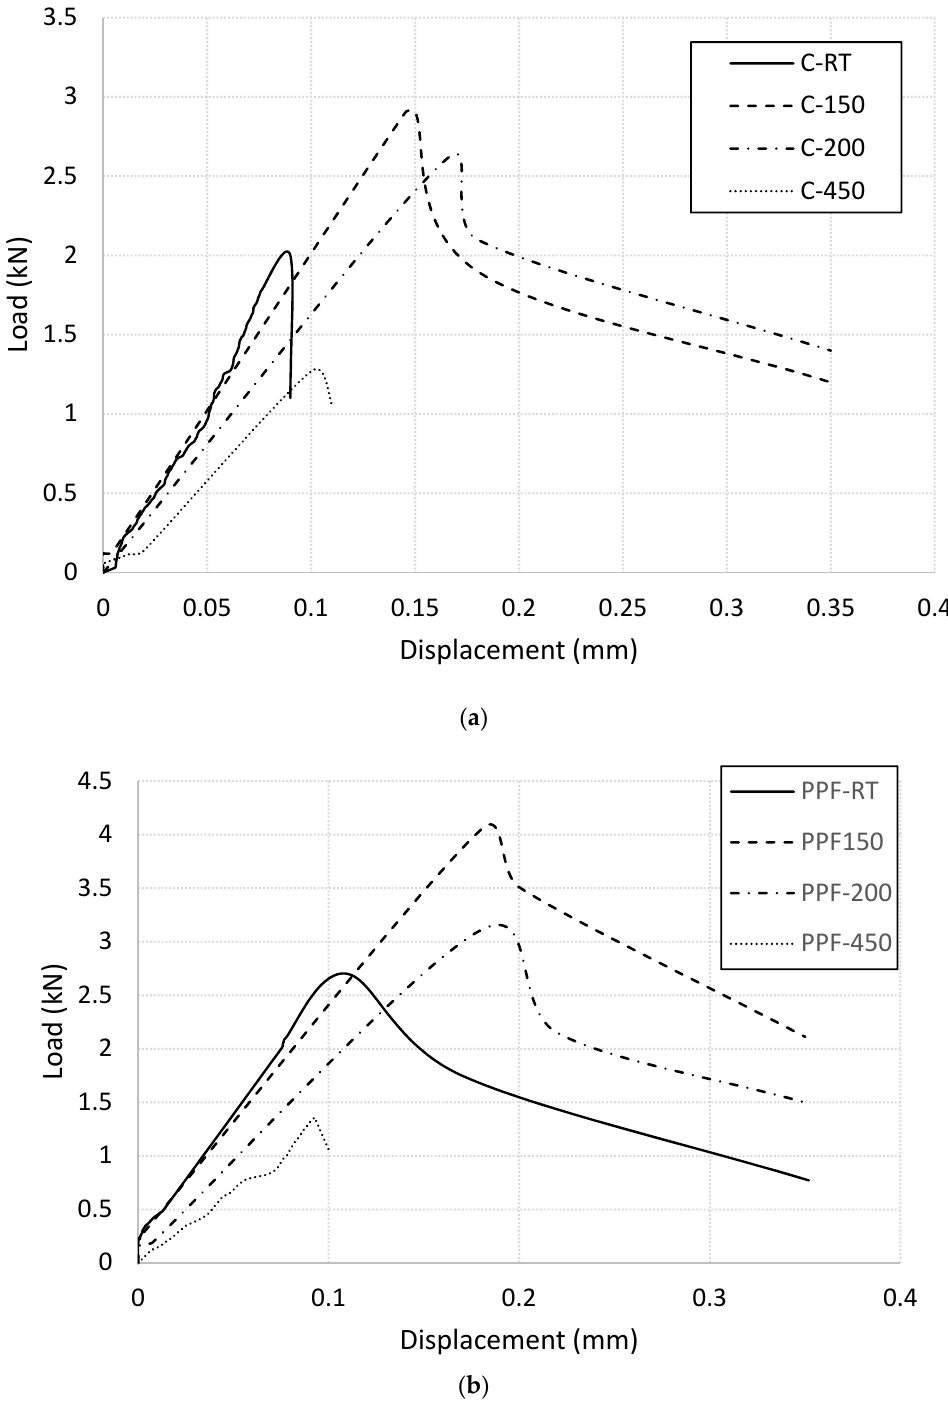
Figure 3. Flexural load-displacement curves at various heating levels ( a ) control specimens ( b ) fiber-reinforced specimens.